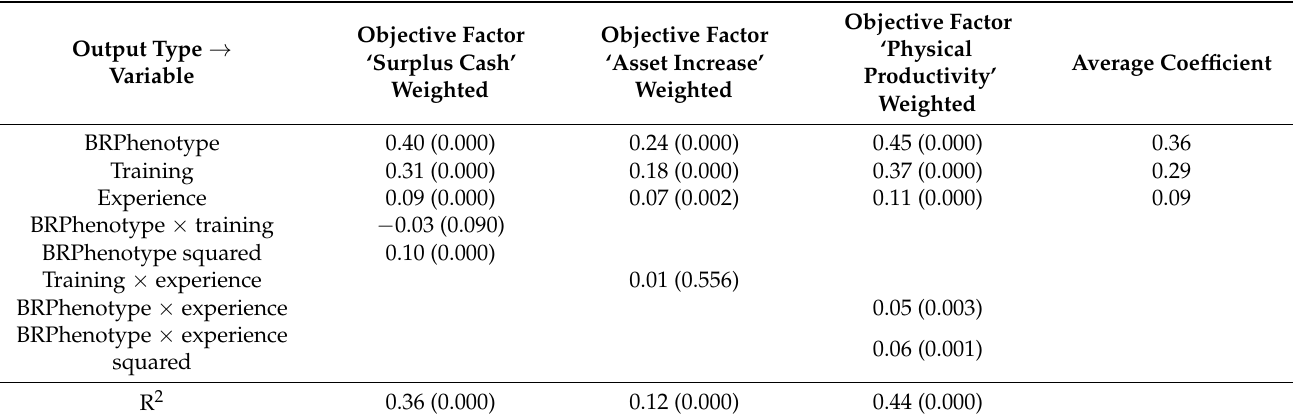
Table 6. The standardized regression parameters for each of the objective modified outputs, together with their significance levels (in